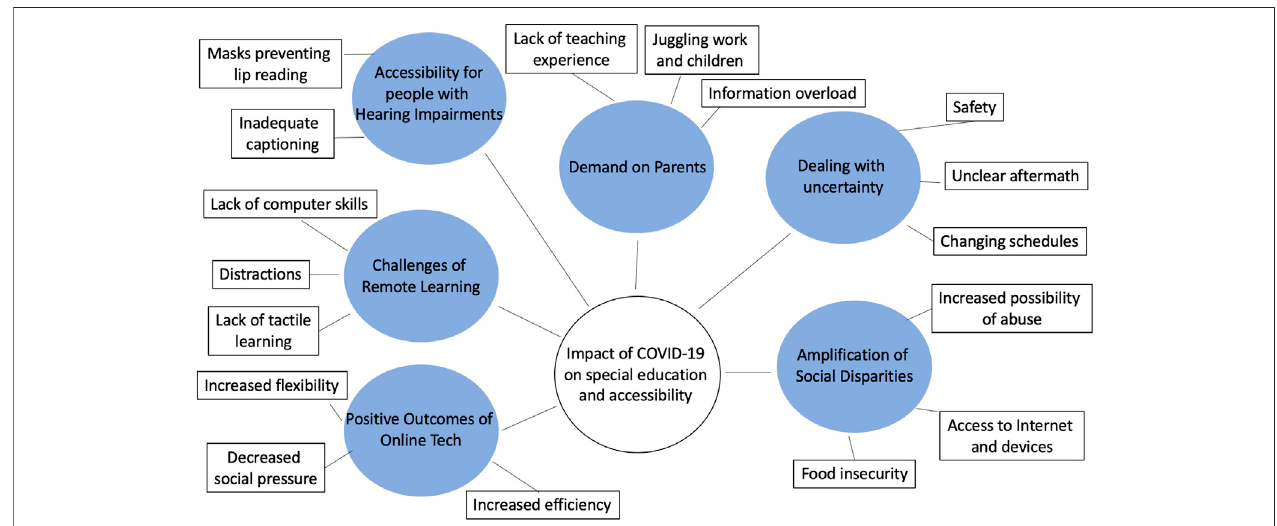
FIGURE 2 | A thematic map of the main theme and subthemes identi fi ed in the analysis.